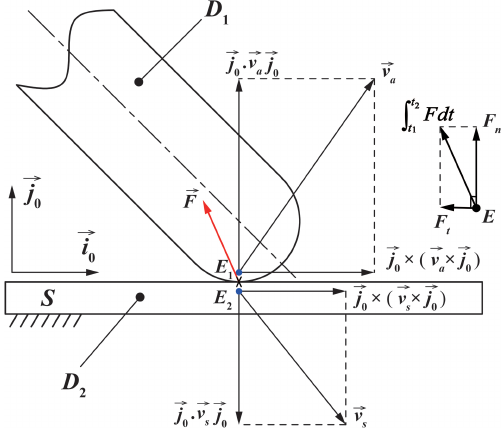
Figure 3. Graphic of the velocity vector for two collision bodies during an impact